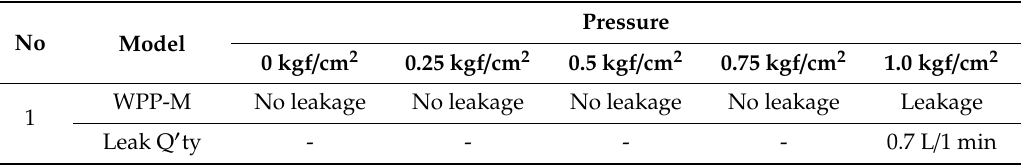
Table 2. Results of water pressure tests.